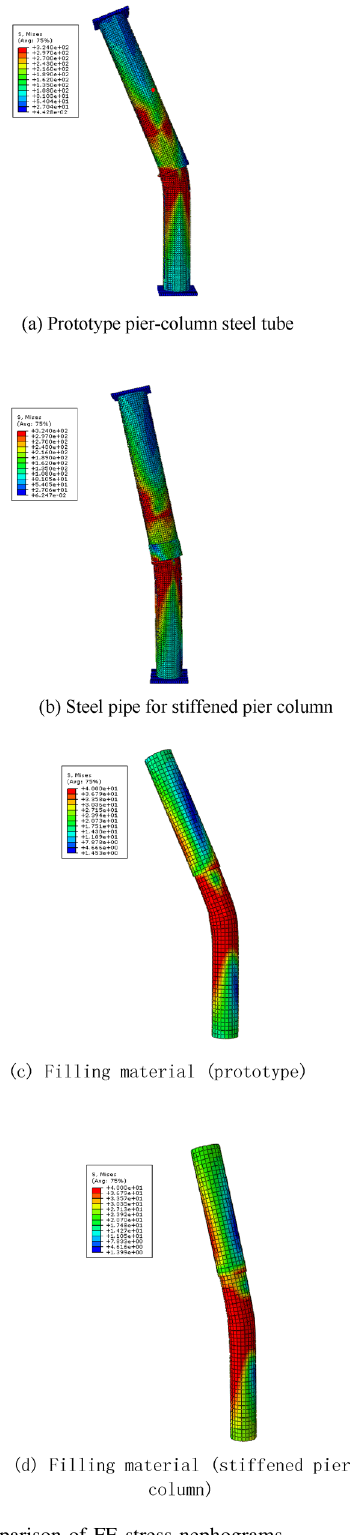
Fig. 20 Comparison of FE stress